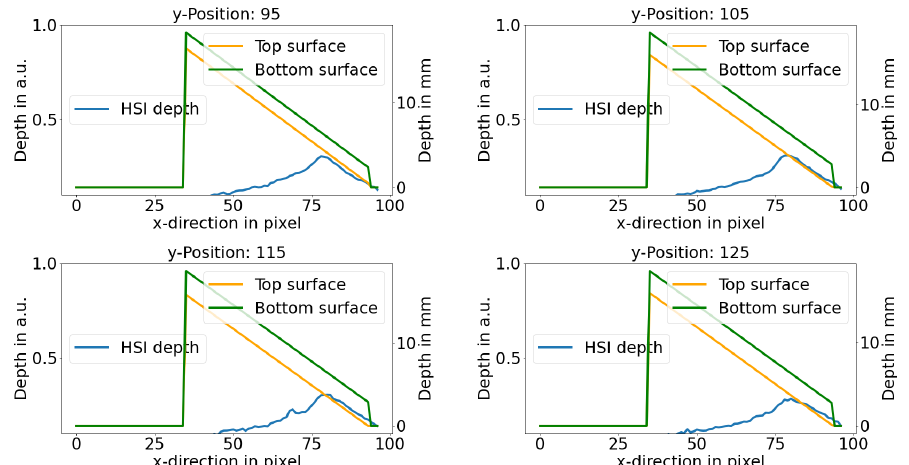
Figure 4. HSI depth parameter along the inclusion for different positions perpendicular to the inclu- sion and the lower and upper depth of the inclusion. The left y-axis shows the depth parameter and the right y-axis the results from the real depth. In all cases, the depth parameter acts linear (marked by red ellipses) with the actual depth up to a maximal depth depending on the optical properties. The green and orange graphs represent the real depth, measured by an OCT and a